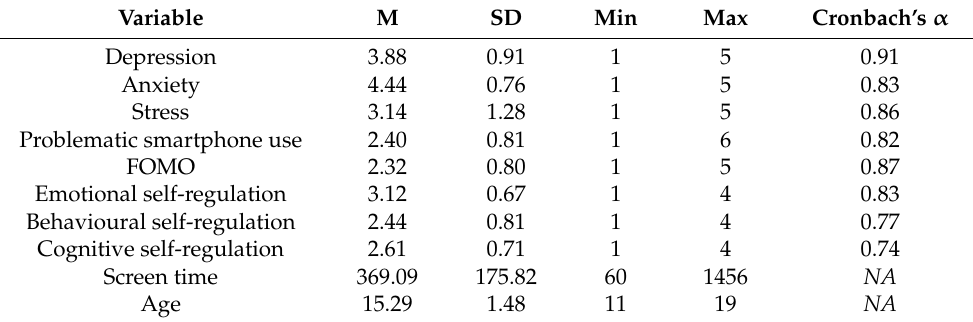
Table 1. Descriptive Statistics of